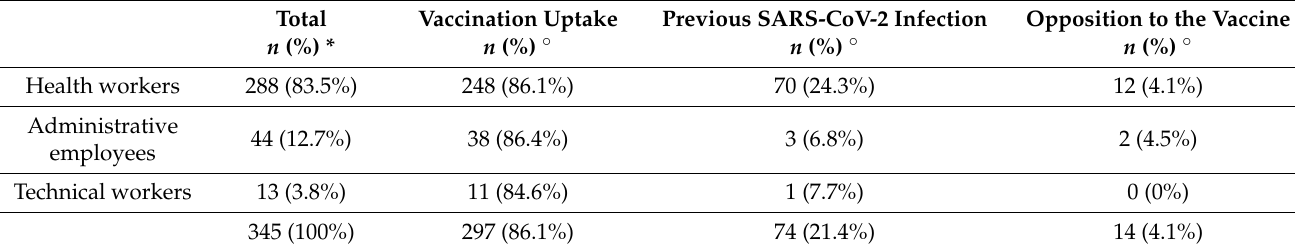
Table 1. Frequencies in absolute values and percentage of investigated outcomes. n =